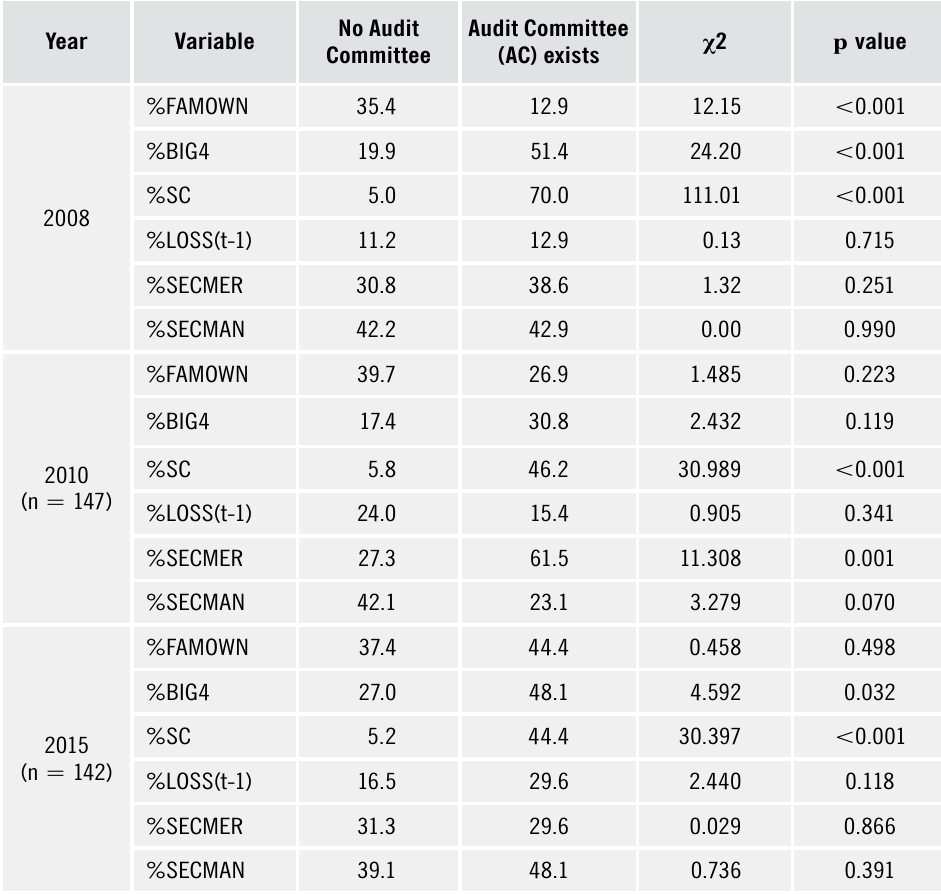
Table 3. Dummy variables’